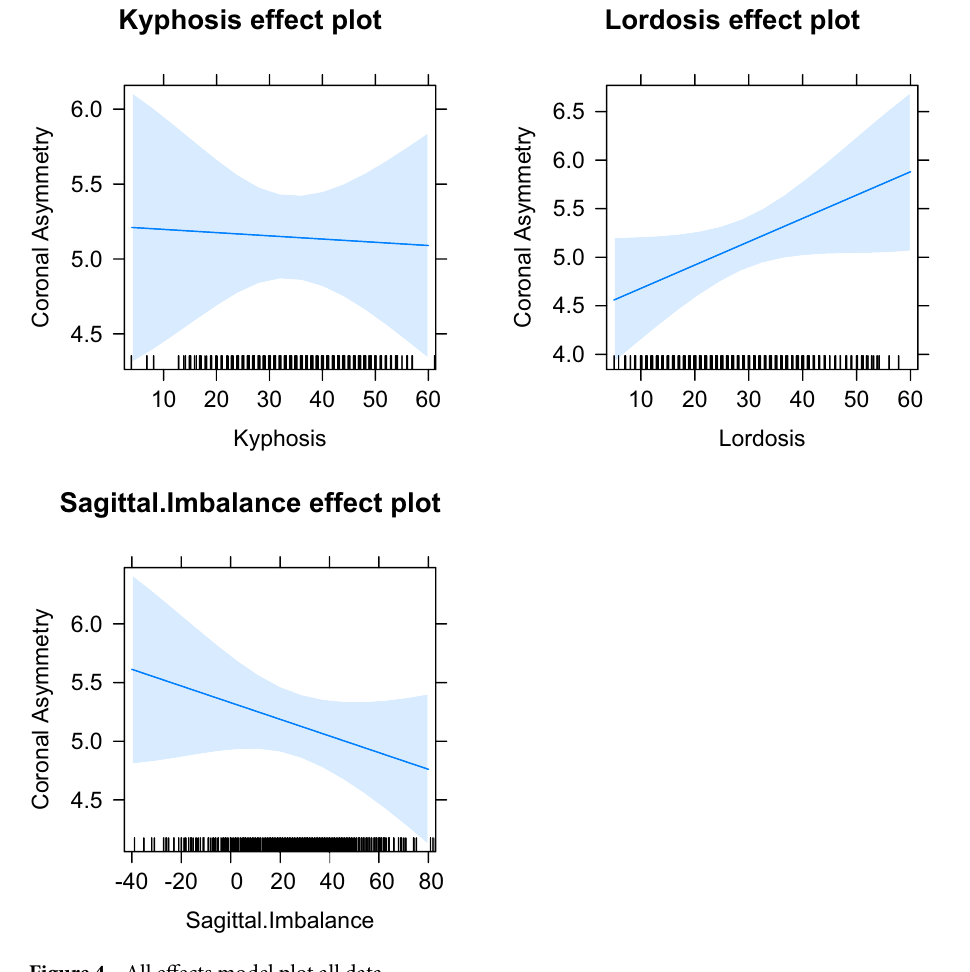
Figure 4. All effects model plot all